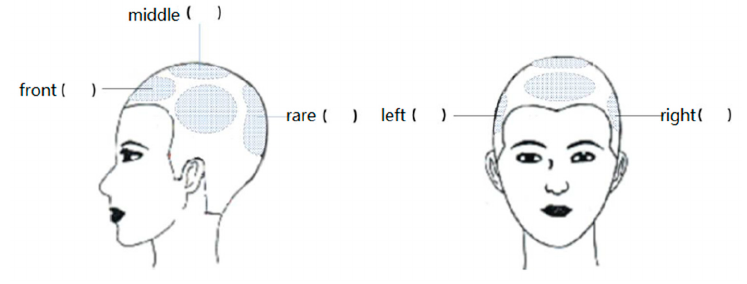
Figure 12. Head area division. Table 1. Pressure test data and helmet score in the host computer.